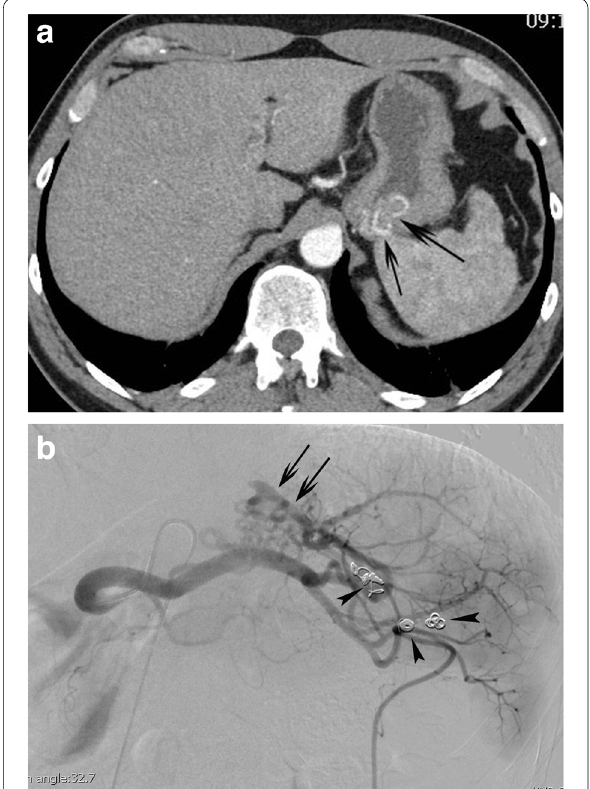
Fig. 1 a Arterial‑phase, contrast‑enhanced CT reveals a cluster of enlarged arteries (black arrows) in the posterior portion of the gastric fundus. b Corresponding selective splenic artery angiography shows a cluster of hypertrophied arterial collaterals (black arrows), between the splenic artery main branch and the upper splenic pole segmental arteries